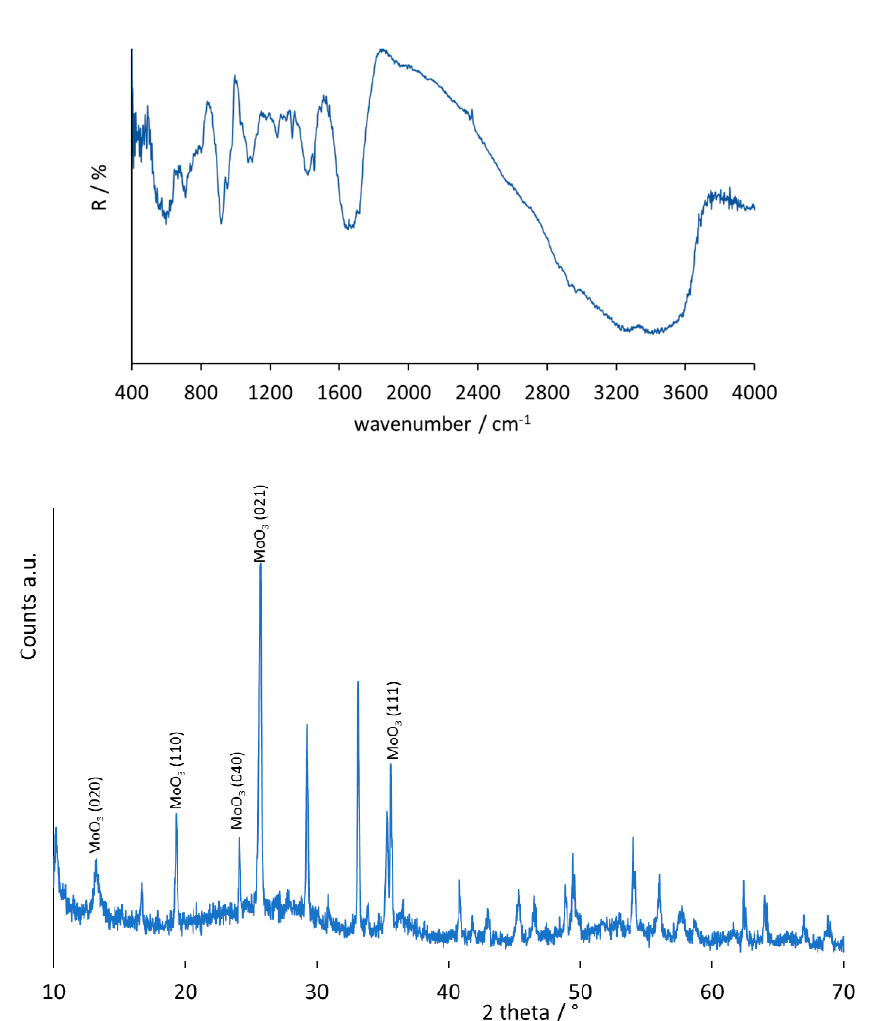
Figure 8. Infrared spectrum ( top ) and X-ray diffraction (XRD) powder pattern ( bottom ) of the MoO 2 NPs after catalysis.